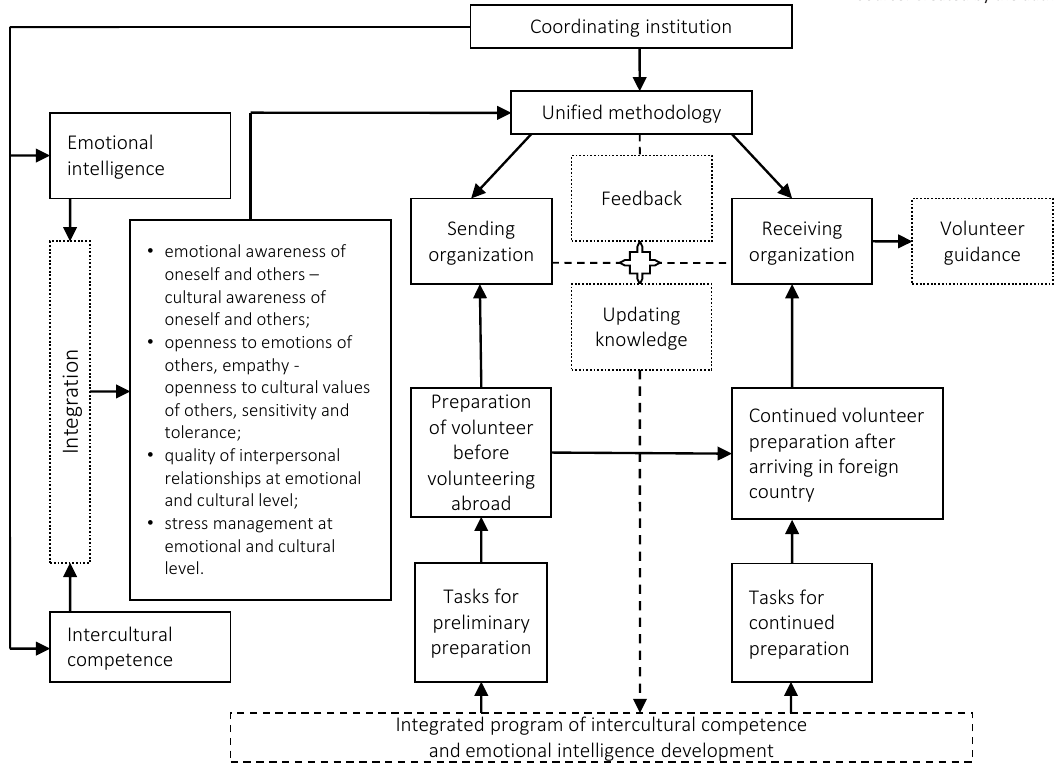
Figure 1. Guidelines of integrated solutions for the increase of volunteer work productivity